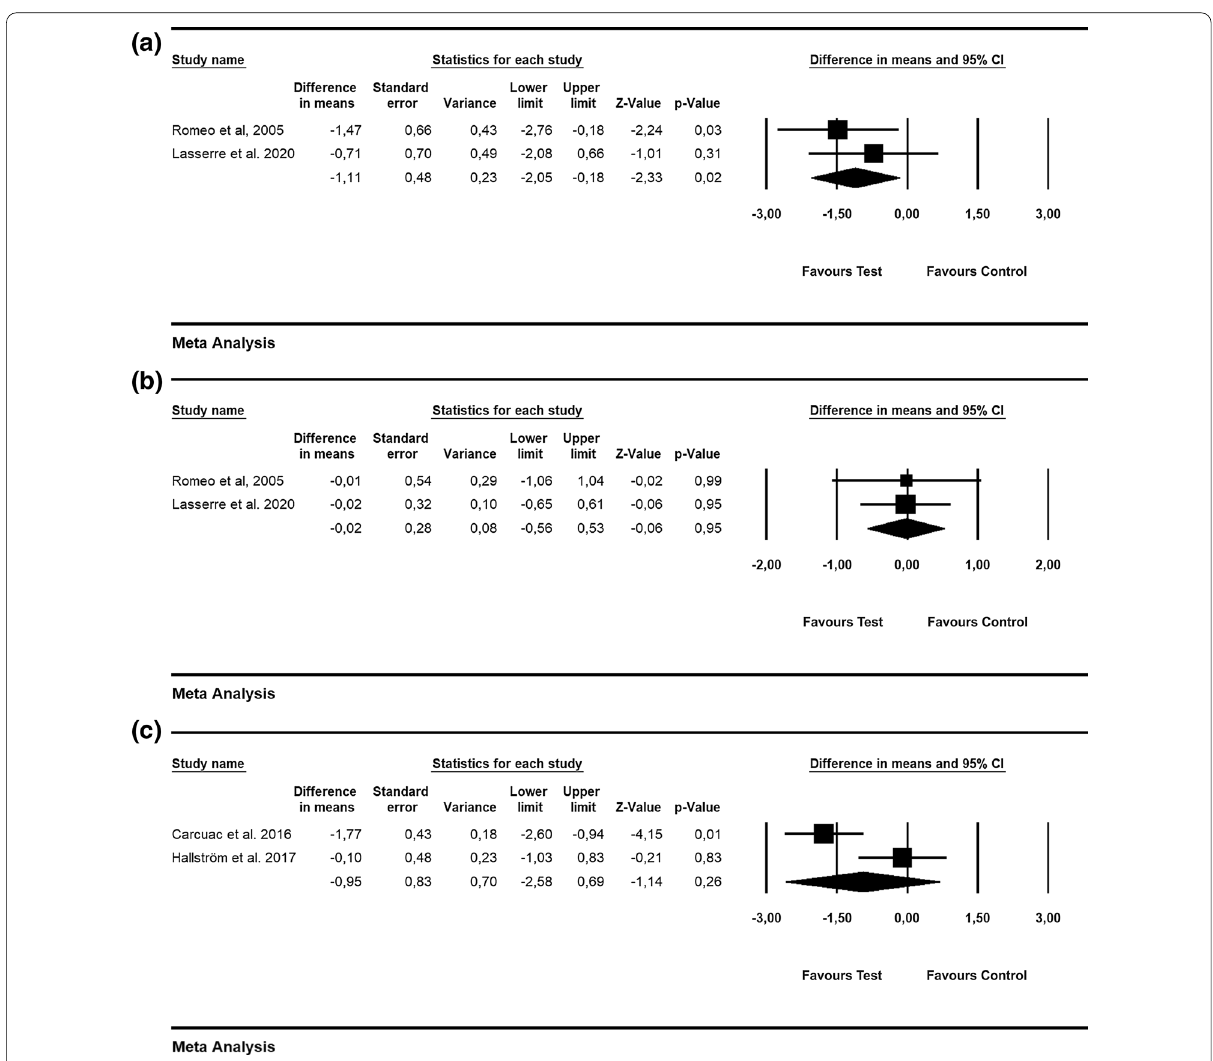
Fig. 4 Forest plot indicating weighted mean difference (95% CI) in the changes of clinical outcomes following non-reconstructive surgical treatment of peri-implantitis. a Adjunctive implantoplasty (implant-level analysis)—PD. b Adjunctive implantoplasty (implant-level analysis)—ML. c Adjunctive systemic antibiotics (implant-level